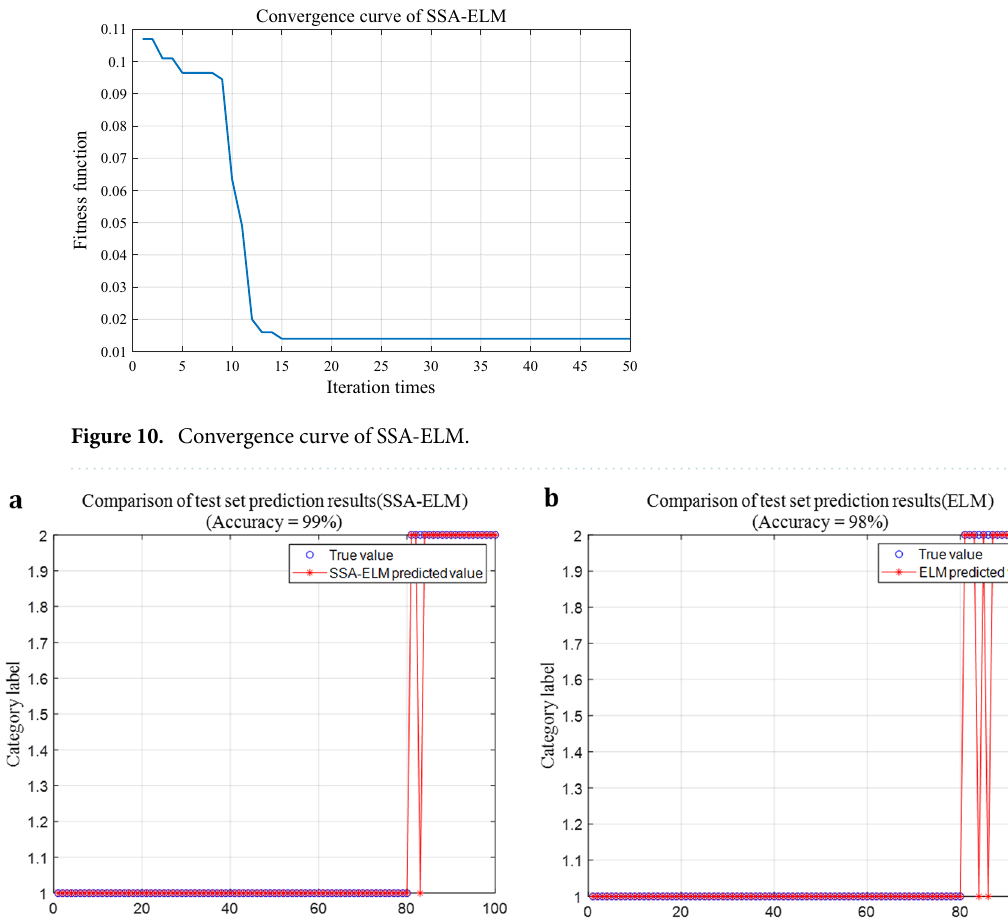
Figure 11. Fault diagnosis accuracy of SSA-ELM and ELM. ( a ) Fault diagnosis accuracy of SSA-ELM. ( b ) Fault diagnosis accuracy of